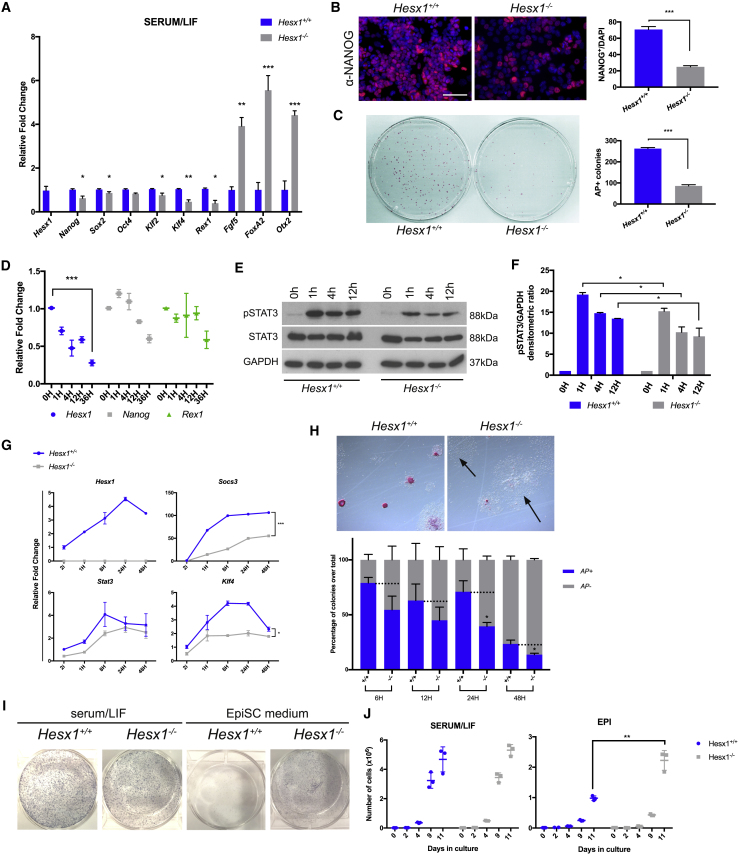
Loss of Hesx1 in ESCs Leads to Reduced Response to LIF and Premature Epiblast Differentiation(A) qRT-PCR evaluating the levels of expression of both pluripotency and commitment-related factors (n = 3 experiments).(B) Immunofluorescence staining against NANOG showing a reduction in NANOG+ cells in Hesx1−/− ESCs (n = 3 independent ESC clones). Scale bar, 50 μm.(C) AP staining after 6 days of culture at clonal density (n = 4 experiments using three ESC clones).(D) qRT-PCR showing that Hesx1, Nanog, and Rex1 mRNA levels gradually decline when Hesx1+/+ ESCs are deprived of LIF (n = 3 ESC clones).(E and F) Western blot detection (E) and quantification (F) showing reduction of pSTAT3 in Hesx1−/− mutant ESCs in response to LIF, with no difference in STAT3 (n = 3 ESC clones in three independent experiments).(G) qRT-PCR time course of ESCs cultured in 2i for three passages before addition of LIF (n = 3 ESC clones in three independent experiments).(H) AP staining for WT and Hesx1−/− ESCs 24 h after LIF starvation. The majority of the Hesx1−/− ESCs cannot retain pluripotency and generate large colonies of disperse flat cells (arrows). Quantification confirms a reduction in the number of AP+ colonies in Hesx1−/− relative to Hesx1+/+ ESCs at all analyzed time points (n = 3 ESC clones and three independent experiments).(I) When cultured in EpiSC medium, Hesx1−/− mutant ESCs generate a higher density of EpiSC colonies compared with Hesx1+/+ controls. In contrast, colony density is similar between genotypes when cells are cultured in serum/LIF.(J) Cellular growth rates in either serum/LIF or EpiSC medium (n = 3 ESC clones in three independent experiments).